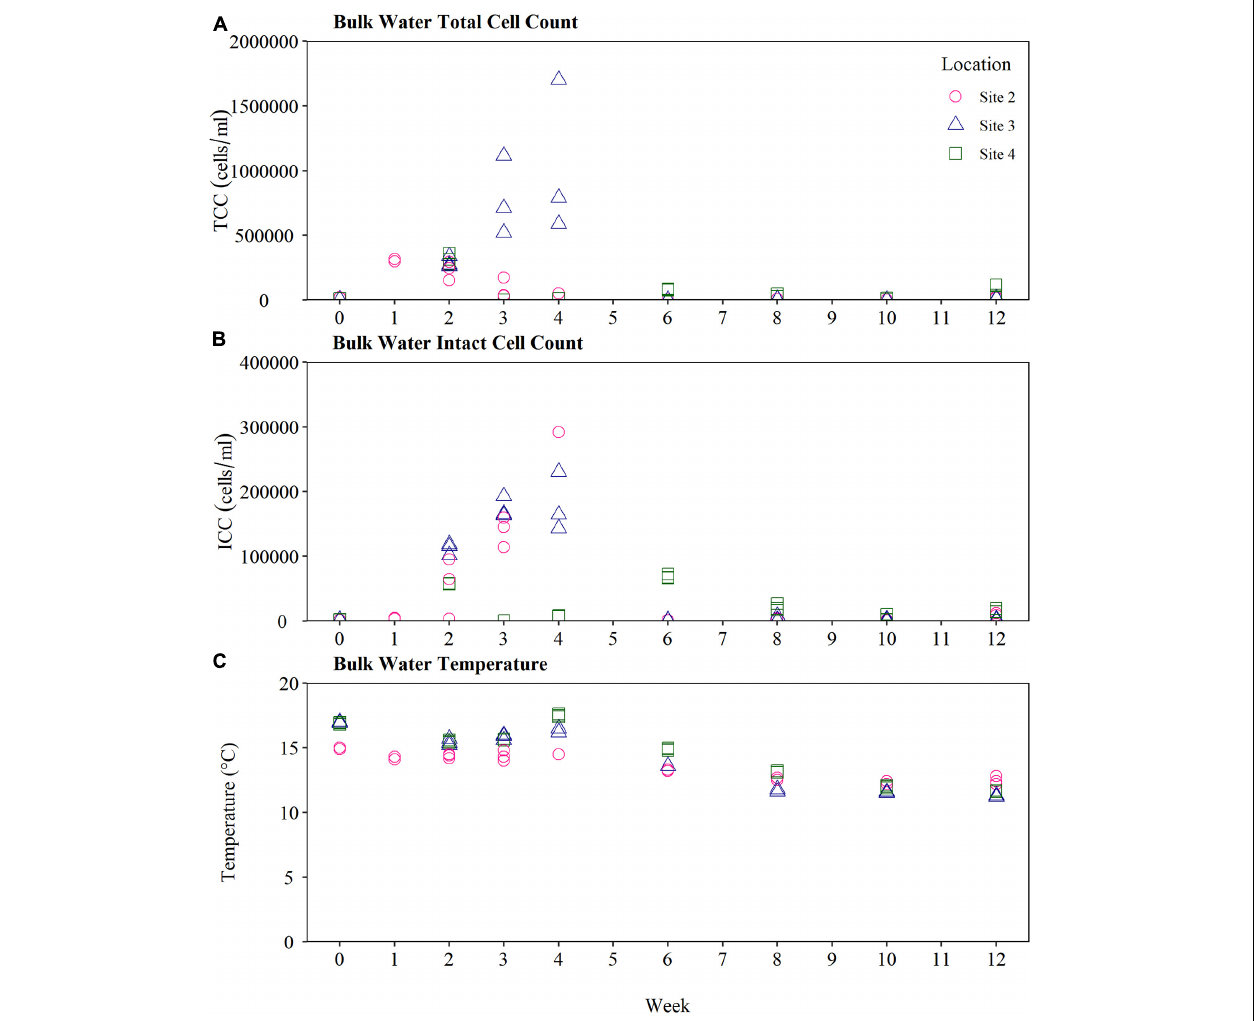
FIGURE 5 | Bulk water quality supplying the biofilm monitoring device at Site 2, Site 3, and Site 4. (A) Total cell count and (B) intact cell count (C) water temperature of the bulk water. Bulk water was samples weekly for the first 4 weeks, and every 2 weeks from Weeks 4 to 12 (n-3 in all cases). TCC, total cell count; ICC, intact cell